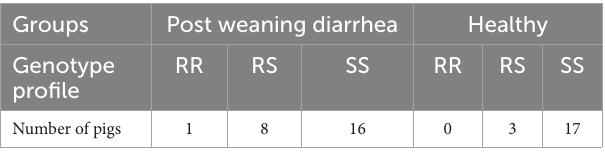
TABLE 3 FUT1 genotypes for ETEC F18 susceptibility between PWD status